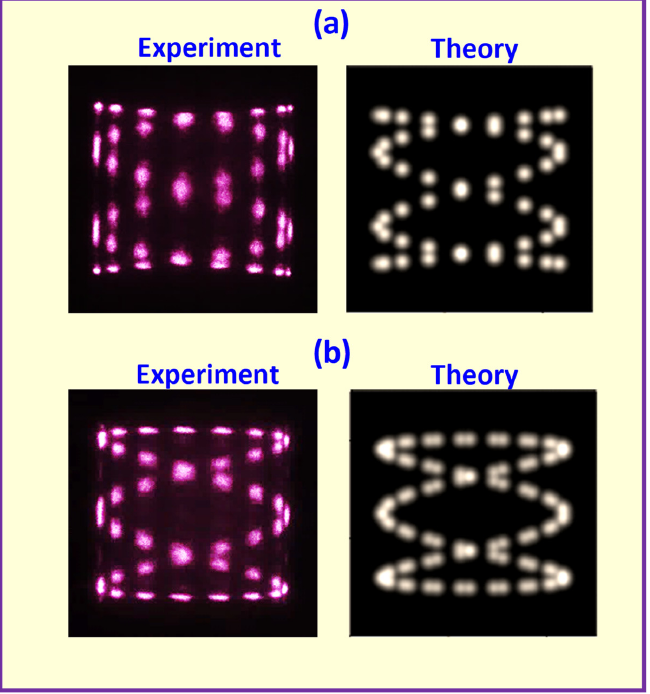
Figure 15. Experimental far-field transverse patterns with the parameters of (𝑃,𝑄) = (1,4) , (𝑝,𝑞) = (−2,6) , (cid:3435)𝑁 (cid:3051) ,𝑁 (cid:3052) (cid:3439) = (300,200) , 𝑀 = 102 , 𝑚 = 1 for the two cases of 𝑛 = 2 : ( a ) 𝜙 (cid:3051) = 𝜙 (cid:3052) = 𝜋/2 ; ( b ) 𝜙 (cid:3051) = 𝜙 (cid:3052) = 𝜋/4 . ( b ) φ x = φ y = π